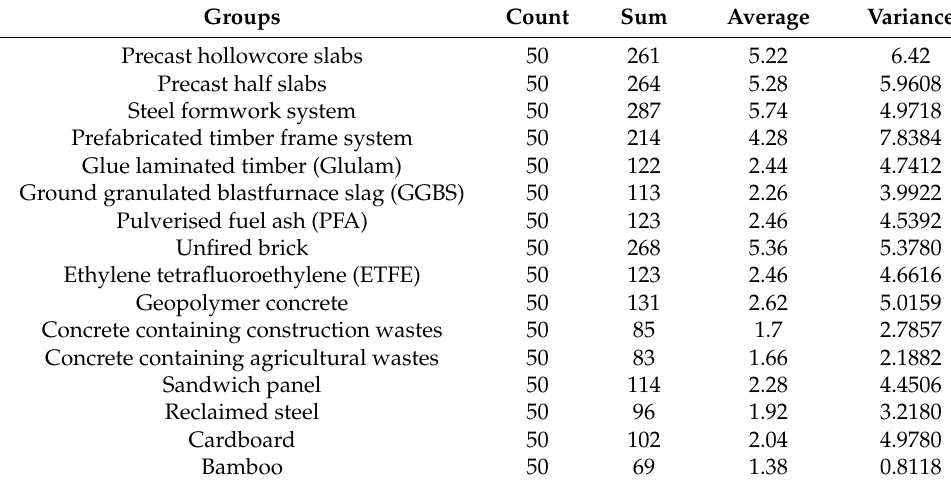
Table 6. Frequency of use of low-carbon building materials.